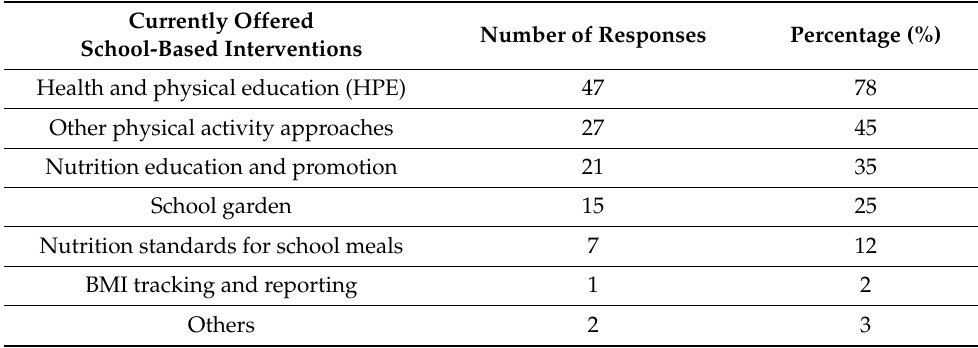
Table 3. Interventions and strategies currently used in Queensland schools for physical health and wellness as reported by school stakeholders.